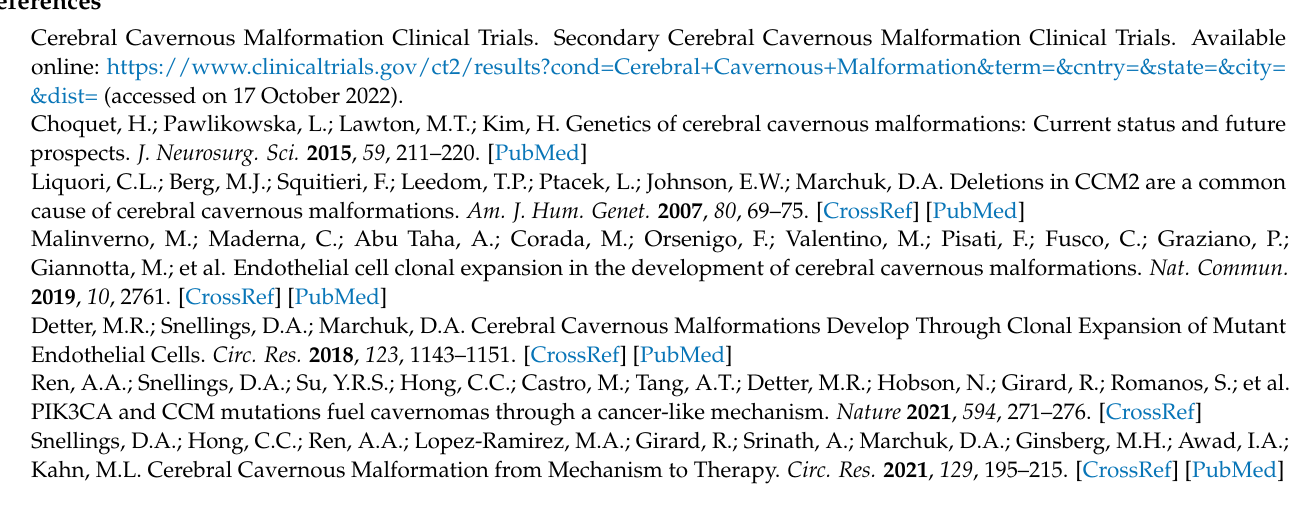
Figure assembly M.A.G. and M.A.; Editorial assistance, R.O.S.; Supervision and funding